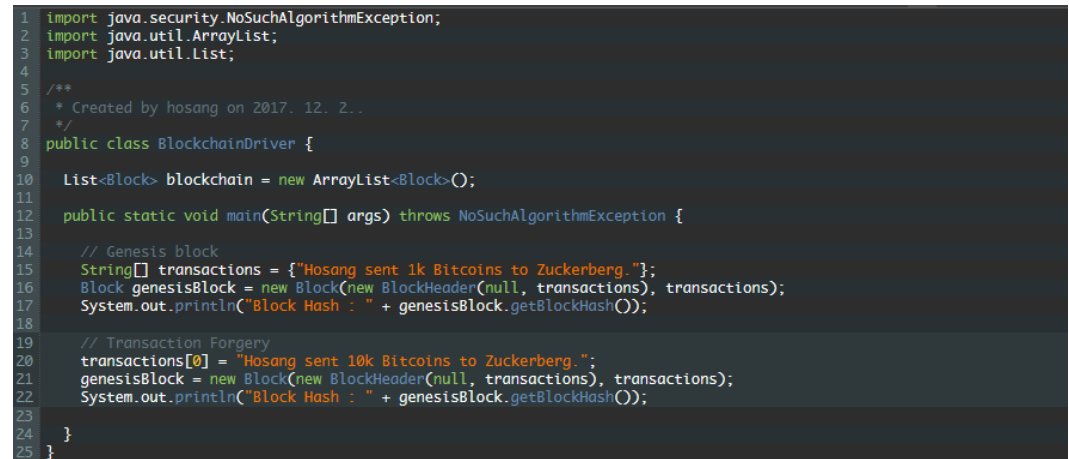
Figure 14. Modification of block hash calculation code. Energies 2018 , 17 , x FOR PEER REVIEW